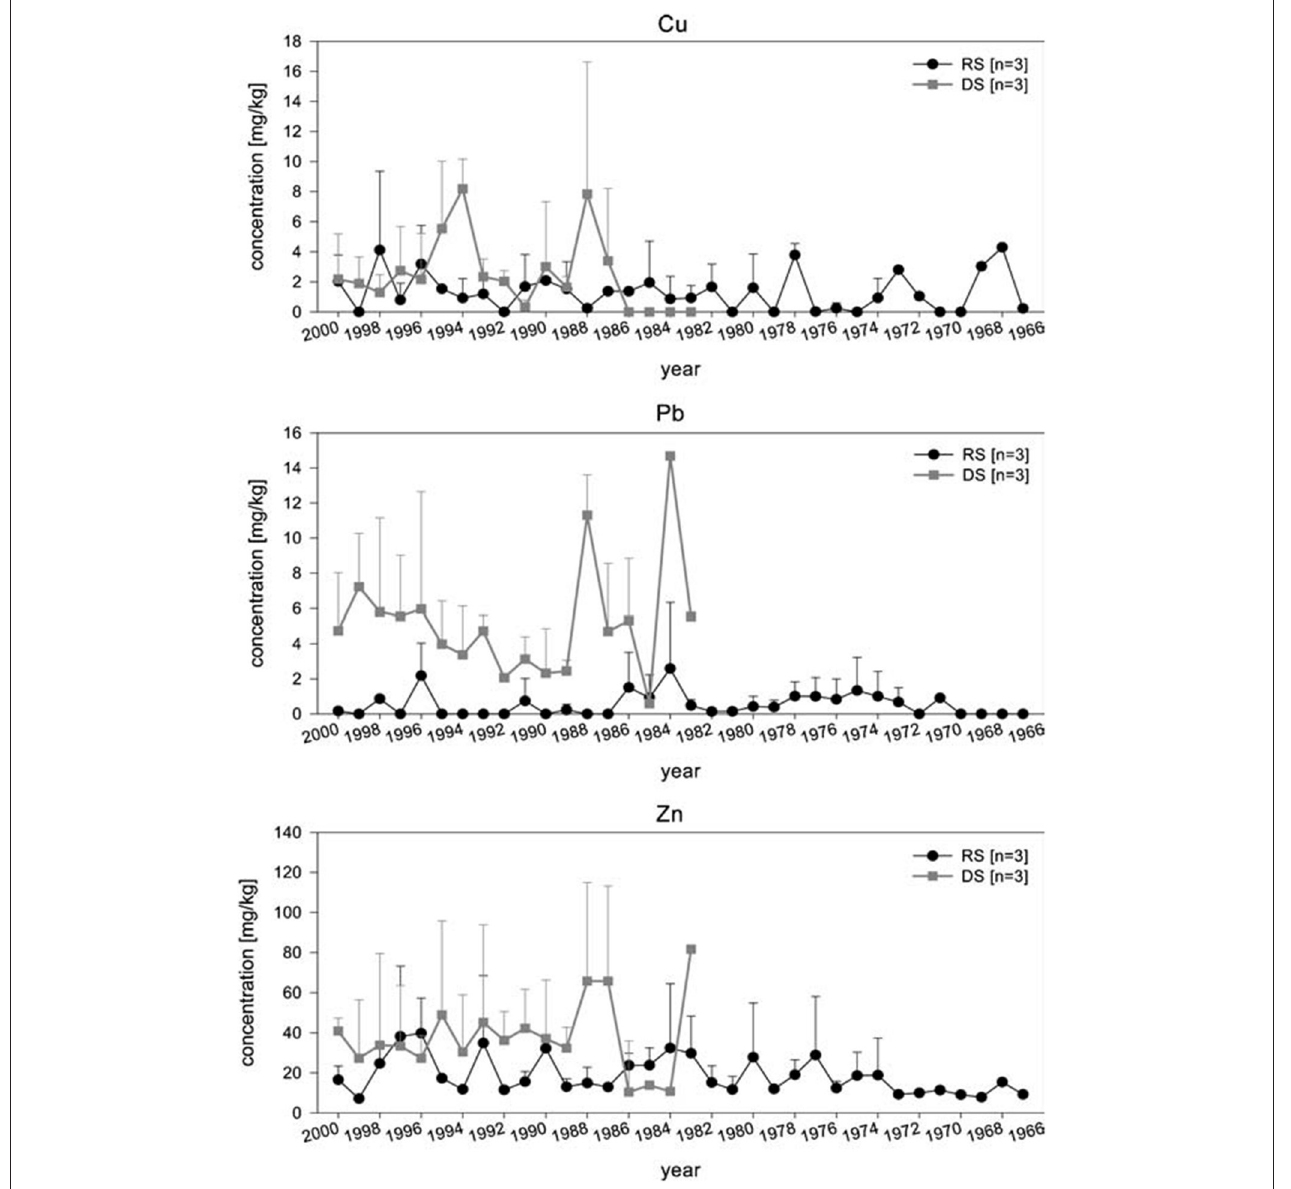
FIGURE 7 | Analysis of Zn, Pb, and Cu concentrations in shells of three specimens, each from the dumping and the reference site were measured using LA–ICP–MS. Applying this method, allows to determine the heavy metal exposure per growth year of A. islandica . Chronological review of heavy metal concentration in the shells of A. islandica from the dumping site (DS) and reference site (RS) in August 2001 using laser ISP–MS. Measurements where performed on the cardinal tooth (Figure from Liehr et al.,